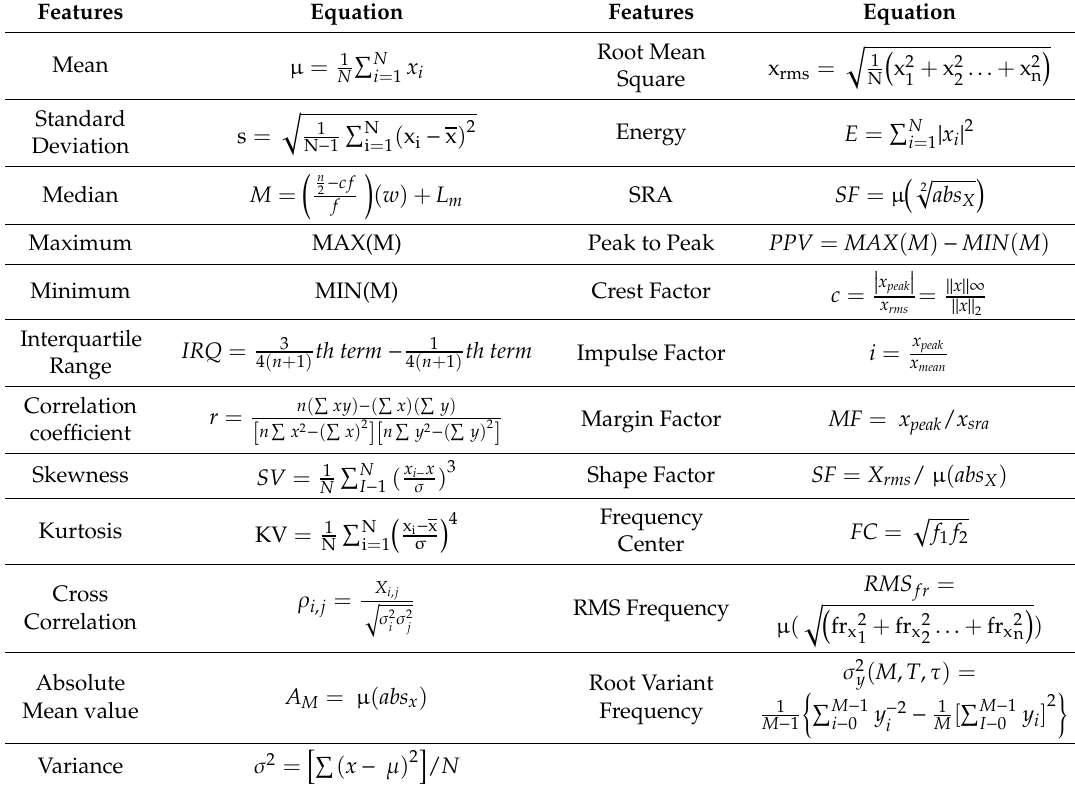
Table 1. Statistical features from sensor